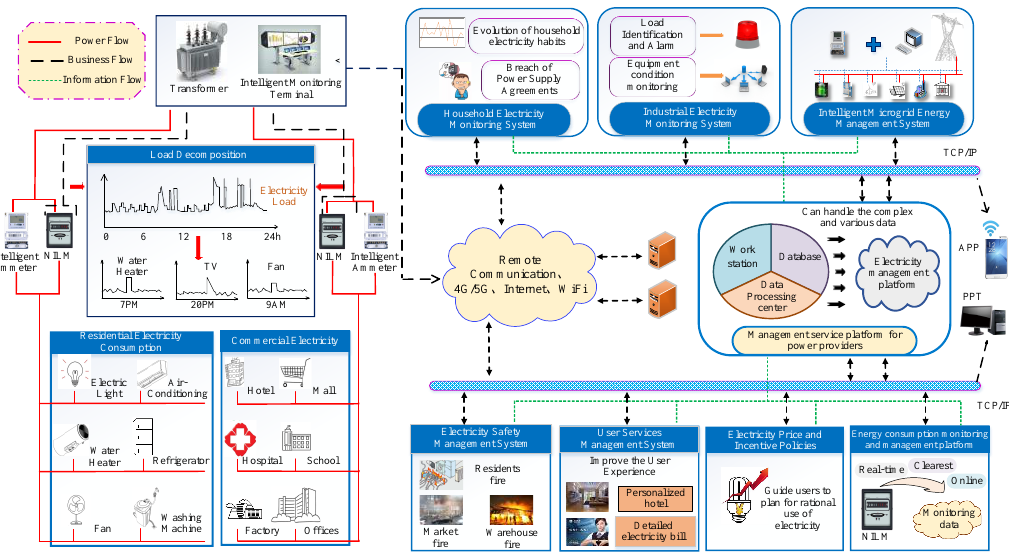
Figure 1. Non-intrusive load monitoring (NILM) system.